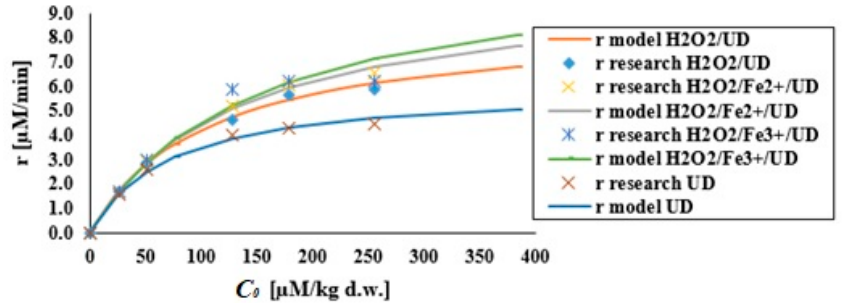
Figure 7. Experimental and modelled initial DEHP degradation rates for processes using the ultrasonic field (pH = 10, acoustic wave intensity — 3.97 W/cm 2 ), H 2 O 2 /UD (pH = 10, DEHP:H 2 O 2 1:1, acoustic wave intensity — 3.97 W/cm 2 ), H 2 O 2 /Fe 2+ /UD (pH = 10, DEHP:H 2 O 2 :Fe 2+ 1:1:1, acoustic wave intensity — 3.97 W/cm 2 ), H 2 O 2 /Fe 3+ /UD (pH = 10, DEHP:H 2 O 2 :Fe 3+ 1:1:1, acoustic wave intensity — 3.97 W/cm 2 ).